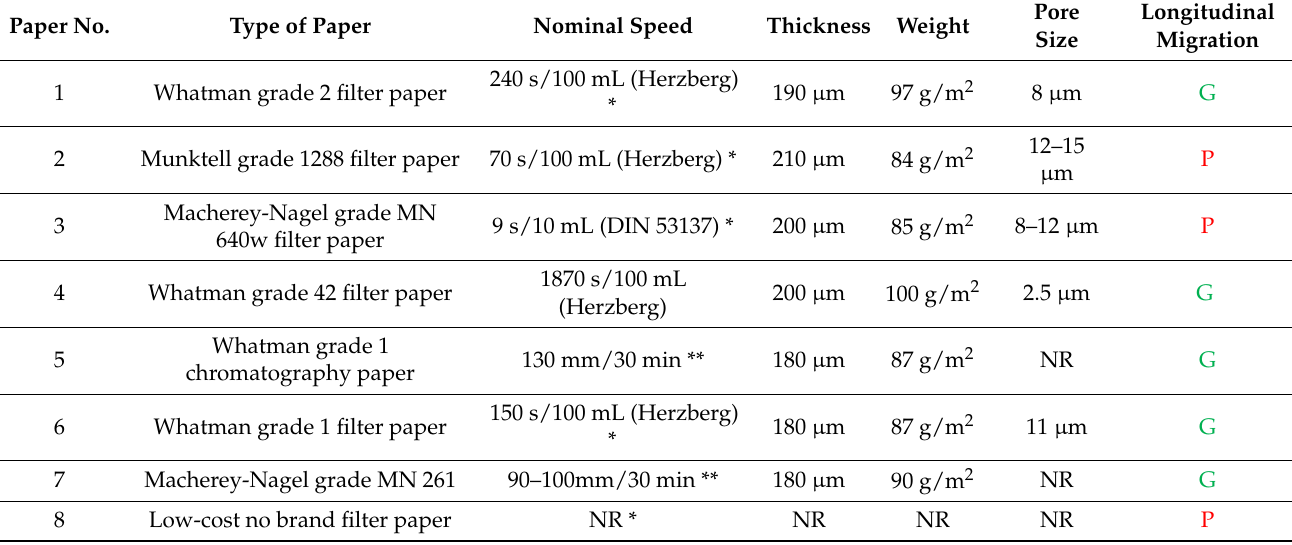
Table 1. Types of papers, specifications and longitudinal migration properties. Specifications are reported as stated by the manufacturers (https://www.mn-net.com/media/pdf/cb/85/77/Catalog-Filtration-EN.pdf; https://d1lqgfmy9 cwjff.cloudfront.net/csi/pdf/e/mk01.pdf; https://beta-static.fishersci.com/content/dam/fishersci/en_US/documents/ programs/scientific/brochures-and-catalogs/brochures/ge-healthcare-whatman-filtration-products-brochure.pdf) (ac- cessed on 12 July 2021).